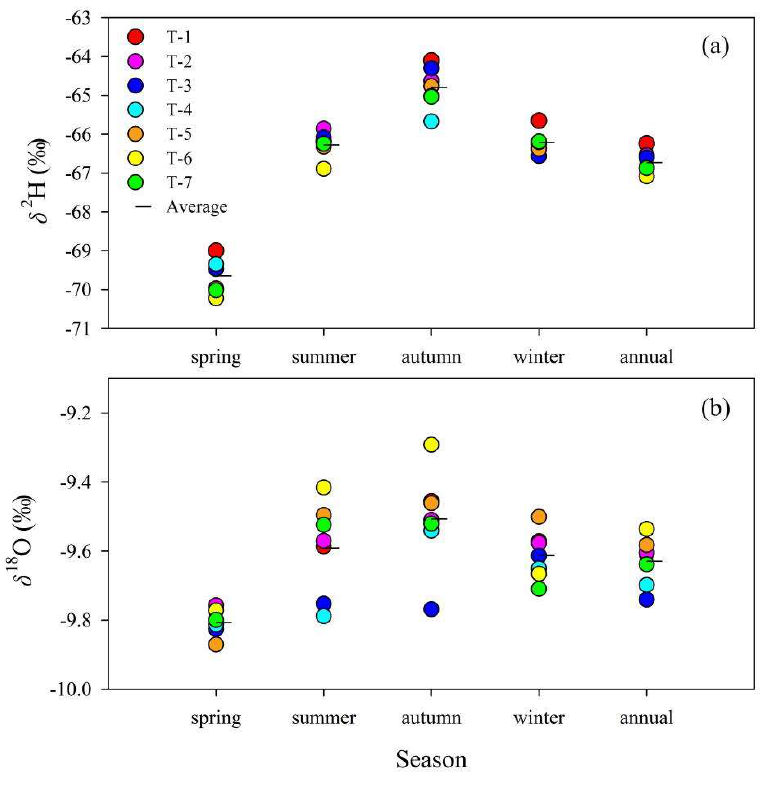
Figure 3. Seasonal variations of δ 2 H and δ 18 O in tap water at each sampling site in Lanzhou from March 2016 to February 2018. ( a ) δ 2 H, ( b ) δ 18 O. Table 2. Seasonal and annual mean values of δ 2 H and δ 18 O in tap water at all sampling sites and their standard deviations (SD) in Lanzhou from March 2016 to February 2018.